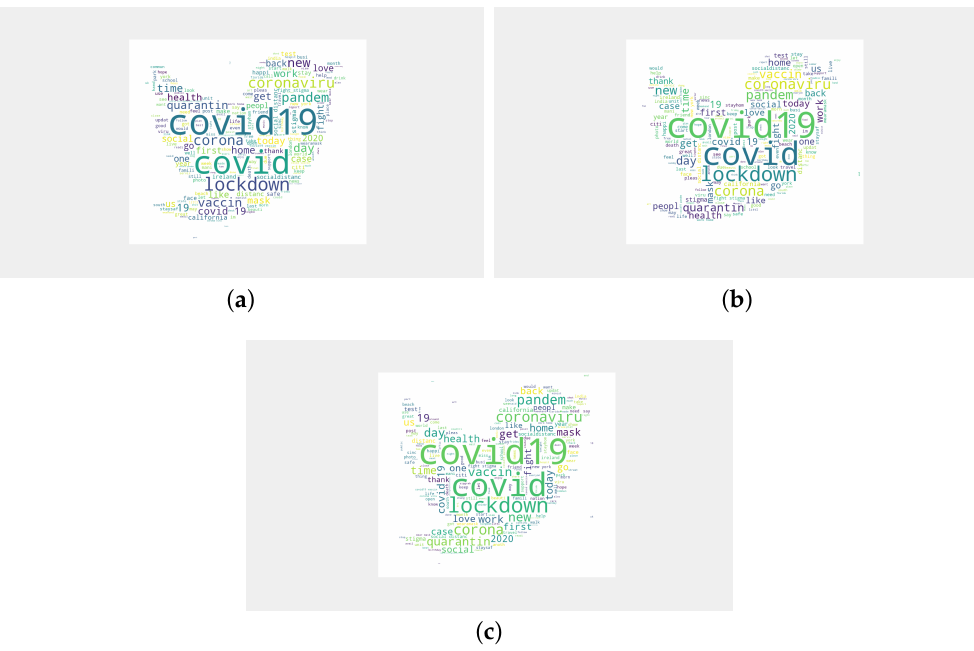
Figure 5. The distribution of ( a ) negative, ( b ) neutral, and ( c ) positive